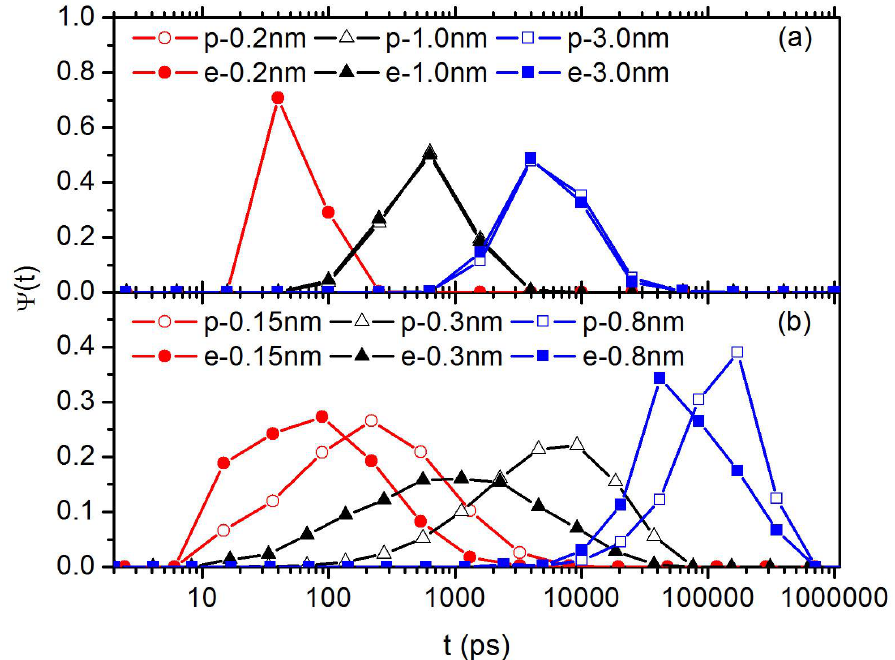
Figure 9. Distributions of exchange and of persistence times at various cutoff distances d for C 60 NP in: ( a ) PP melt; and ( b ) PS melt. Symbols “p” and “e” in legend represent persistence time and exchange time,